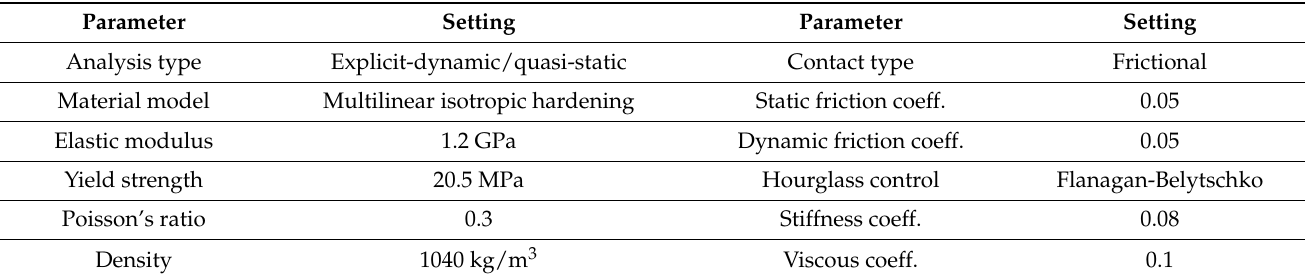
Figure 6. FE model of novel cell under lateral load. Table 1. FE analysis